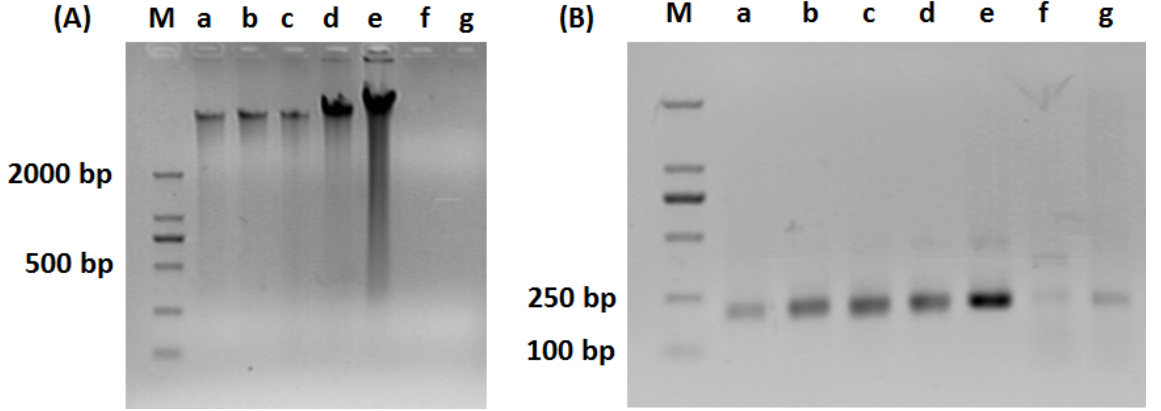
Figure 1. Agrose gel electrophoresis of ( A ) total DNA extracted from water sample